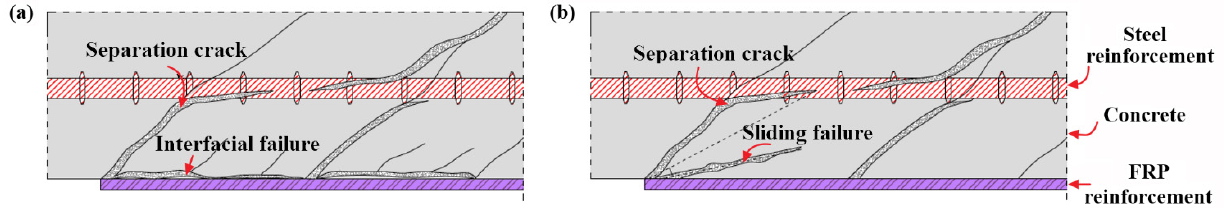
Figure 12. Cracking characteristics of mixed mode of end debonding failure: ( a ) mixed mode of interfacial debonding and cover separation; and ( b ) mixed mode of cover separation and sliding failure.